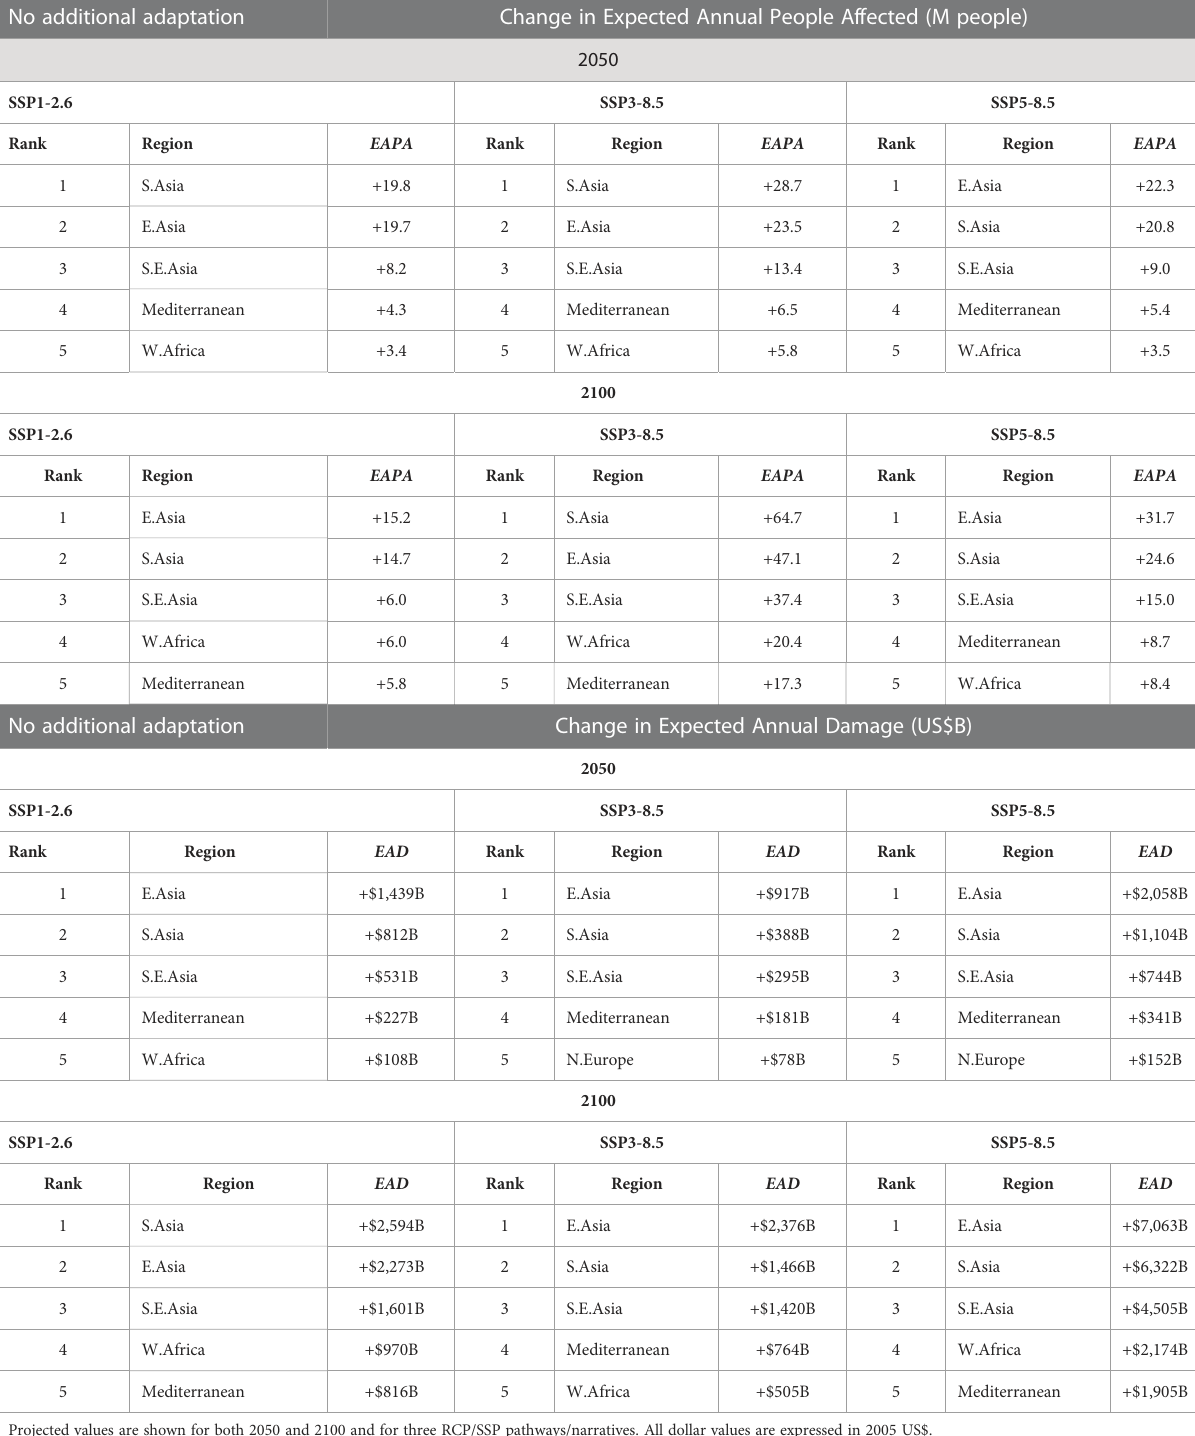
TABLE 3 Regional ranking of changes in EAPA and EAD relative to 2015 for the scenario of no additional adaptation [assumes that the fl ooding extent increases in the future with no changes in coastal defences and that population and GDP change with